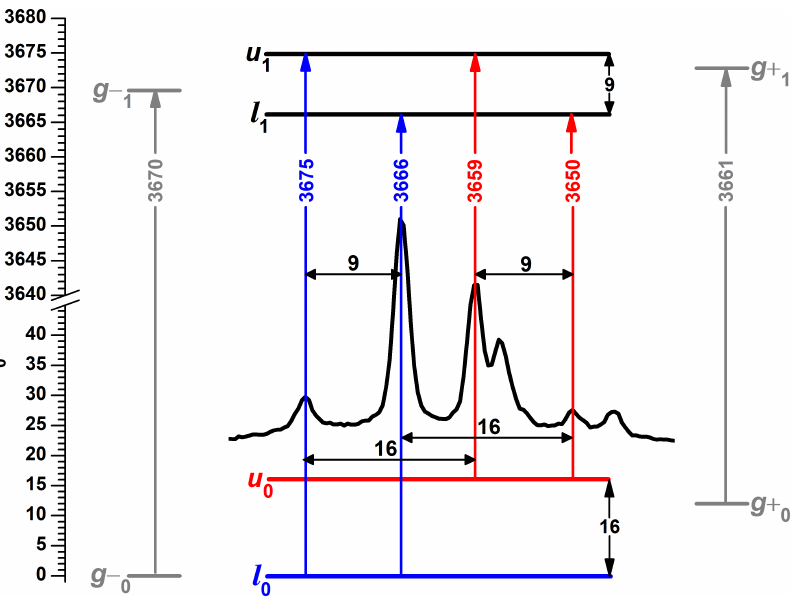
Figure 4. Raman spectral pattern in the OH stretching spectrum of α -fenchol with repeating sepa- rations (black horizontal double-headed arrows) translated into torsional splittings (black vertical double-headed arrows). The ground state l 0 and transitions originating from it are colored blue, for the first excited torsional state u 0 likewise red, for hypothetical localized g − and g + states gray, the latter based on DLPNO-CCSD(T)/aug-cc-pVQZ//PBE0-D3(BJ)/may-cc-pVTZ calculations with shifted harmonic OH stretching wavenumbers [51]. l stands for lower and u for upper torsional state, the index 0 or 1 indicates the OH stretch quantum